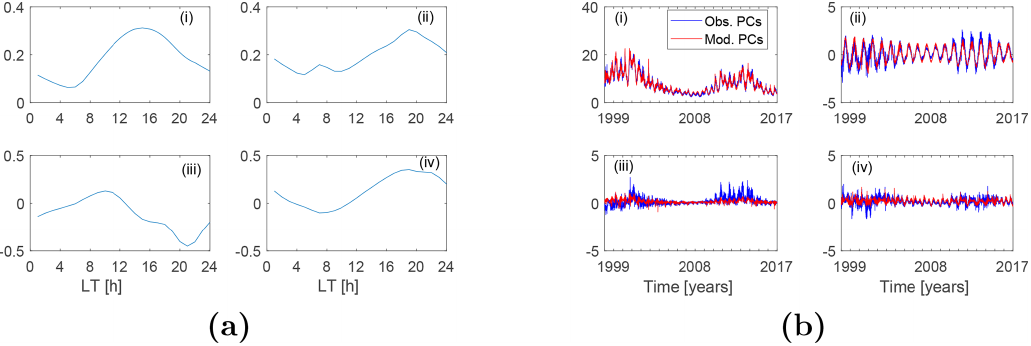
Figure 6. (a) The first basis modes of the first four first-layer expansion coefficients. (b) The expansion coefficients (blue) and their modeled values (red) for the basis modes in (a)